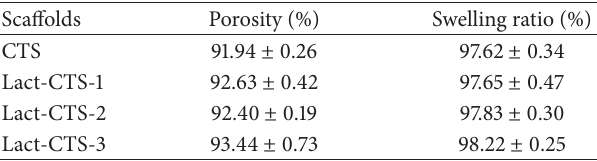
Table 1: Porosity and swelling ratios of CTS and Lact-CTS